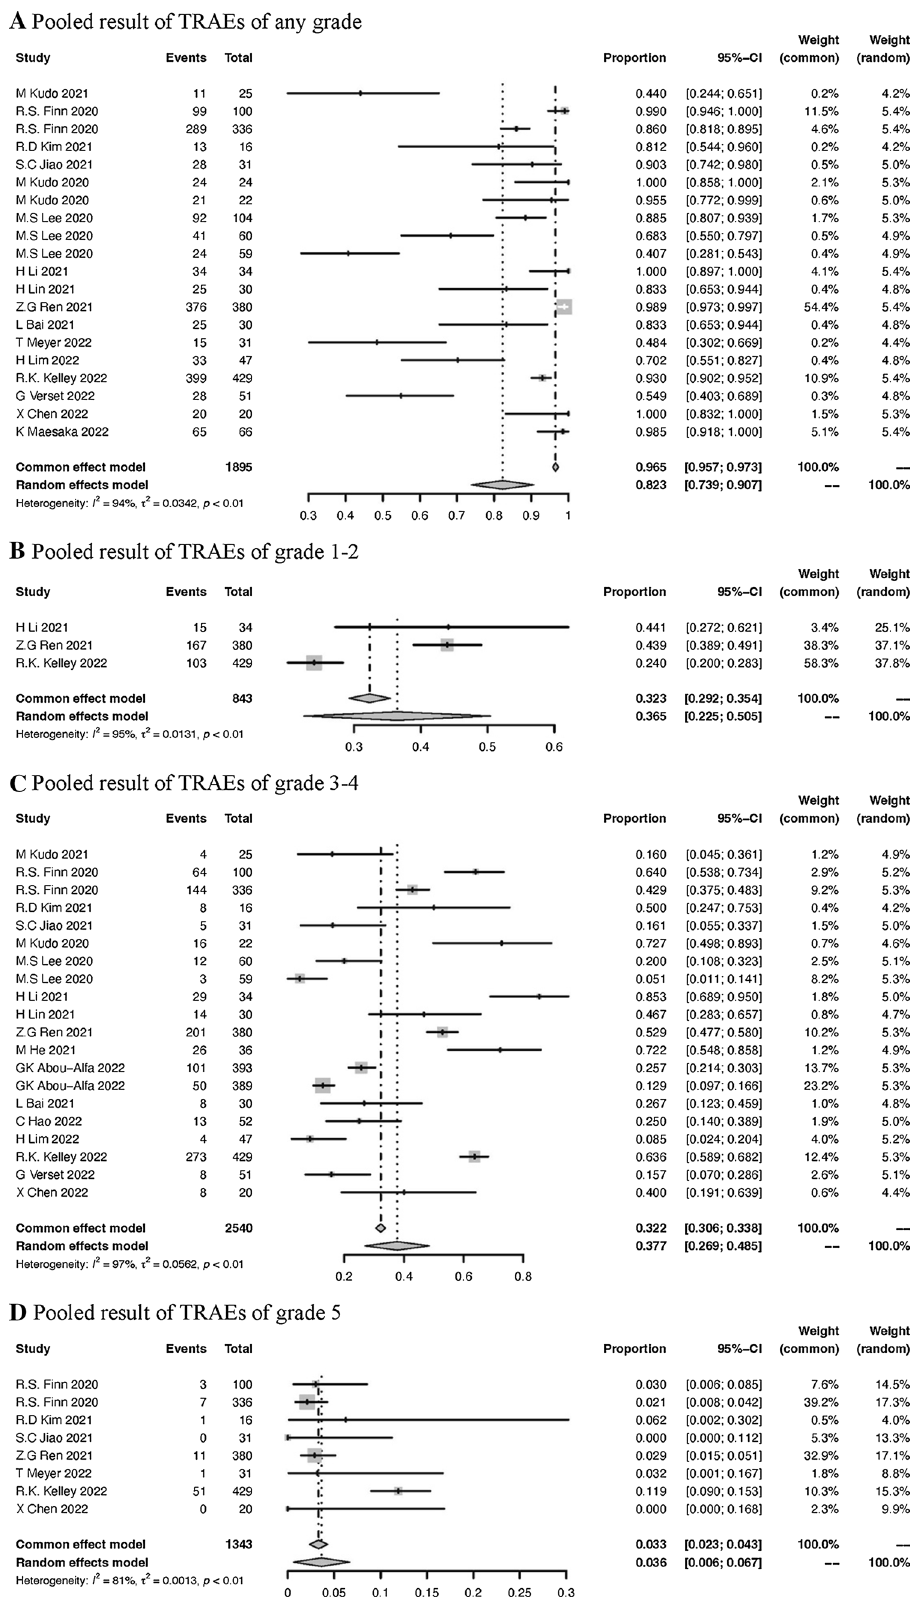
Fig. 7 Pooled results of